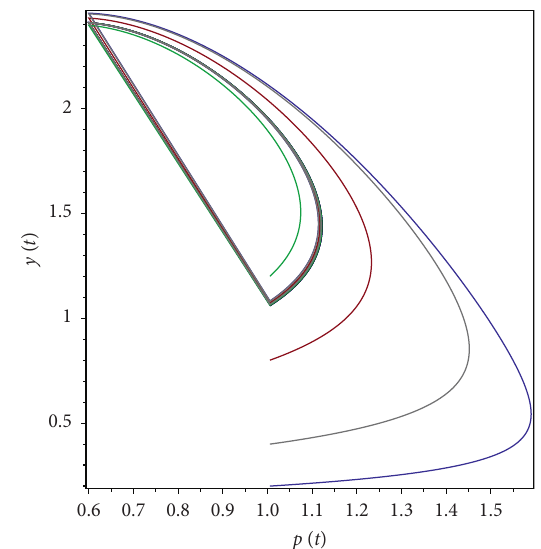
Figure 6: Phase portrait and time series of system (7) when F k � 1 . 8 , a � 0 . 15 , τ � 0 . 6 , p � 0 . 6 , θ � 0 . 8 , δ � 0 . 65 , and β � 0 . 4.